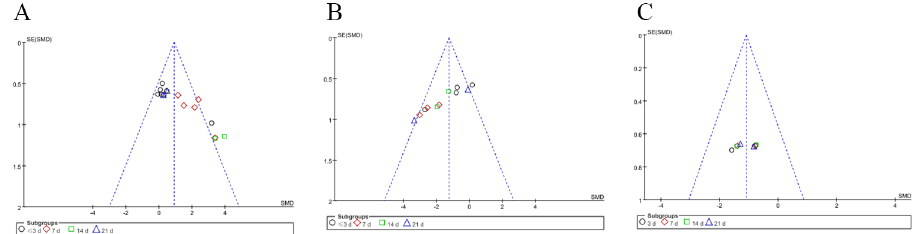
Fig 5. Funnel Plot of MDA (A), SOD (B) and GSH (C) Data. SE: standard error; SMD: standard mean